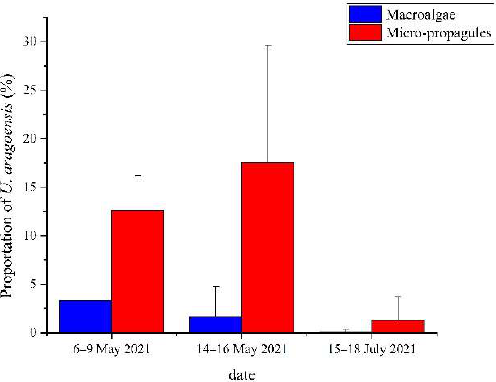
Figure 5. Average proportion of U. aragoensis in the floating green macroalgae and micro-propa-